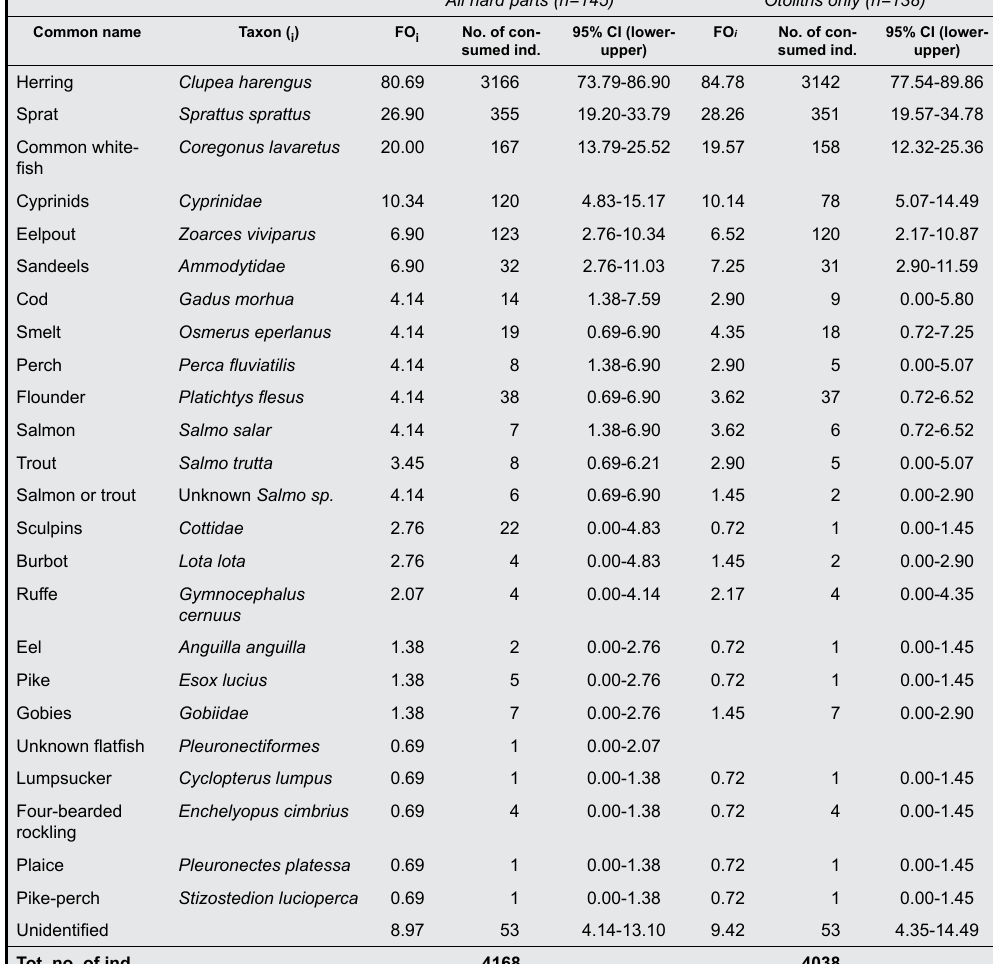
Table 6. Percent frequency of occurrence (FO i ) with upper and lower range of the 95% confi - dence interval (CI) and minimum number of consumed individuals for prey taxa identified from digestive tract contents. FO i is based both on all recovered hard-part structures and on otoliths only, where n equals the number of seals containing diagnostic